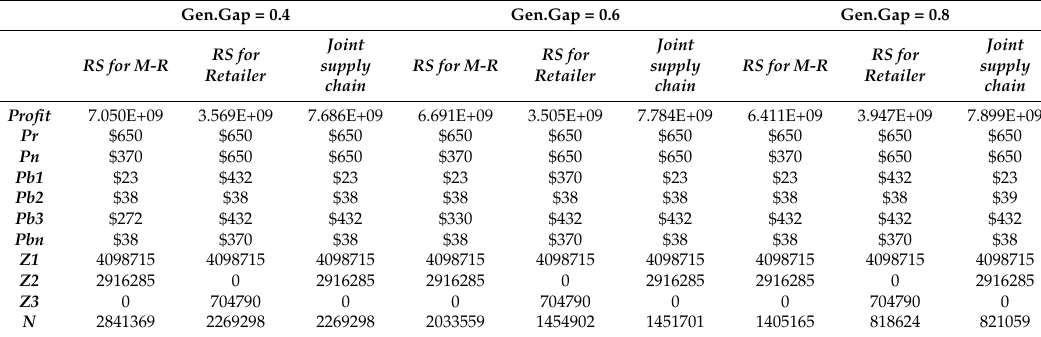
Table 10. The results of product performance analysis.